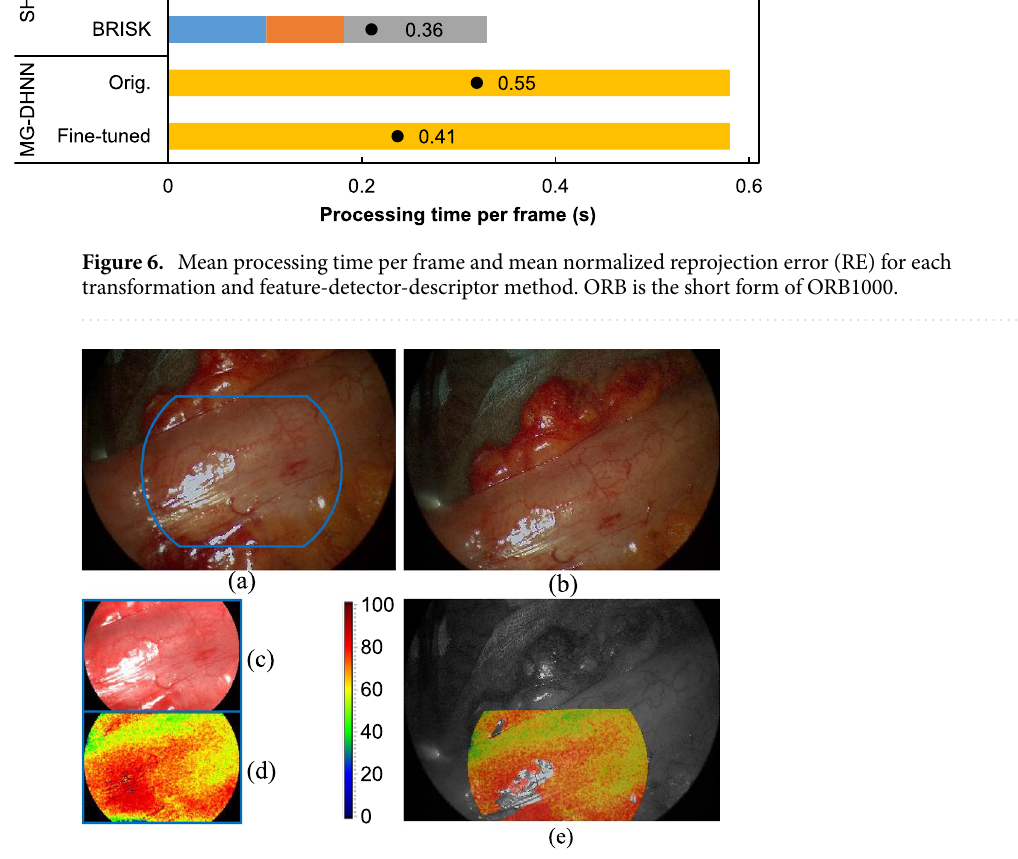
Figure 7. Augmentation of in-vivo video data with HSI. ( a ) Start frame from the color sensor acquired during the HSI record. The blue outline indicates the region visible in HSI. ( b ) An exemplary target frame of the video, 20 s after HSI was performed. ( c ) Pseudocolor image reconstructed from hyperspectral data. ( d ) Static color map representing the tissue oxygenation according to the color scale. ( e ) Semitransparent overlay of the oxygenation map and the grayscale of the target frame after registration and